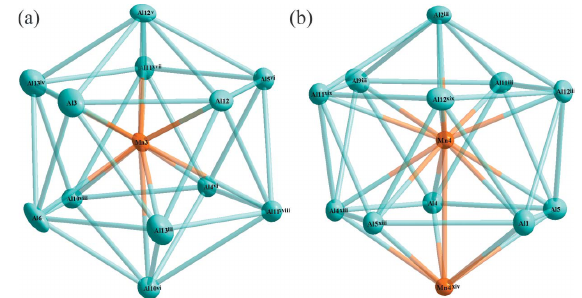
Figure 3 ( a ) The polyhedron formed around the Al3 atom at the 4 c site; ( b ) the environment of the Al3 atom with displacement ellipsoids given at the 90% probability level. [Symmetry codes: (iii) (cid:3) x + 1